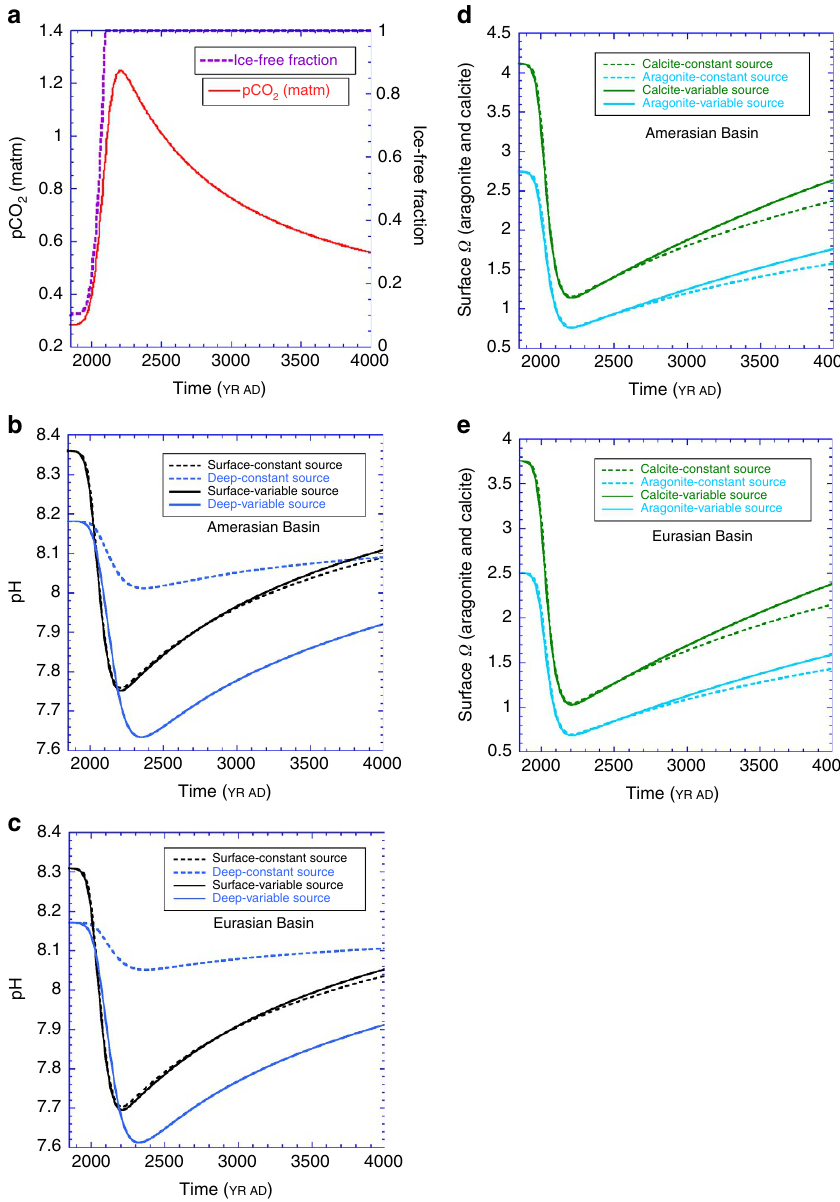
Figure 3 | Calculated pH and surface CaCO 3 saturation of the Arctic basins. ( a ) The pCO 2 created by the extended IS92a carbon emission scenario 24 and the ice-free fraction of the surface Arctic Ocean 3 as used in these calculated results. ( b , c ) pH in surface box and deep box (average) in Amerasian Basin and Eurasian Basin, respectively. ( d , e ) Carbonate saturation state for both aragonite and calcite in surface box in Amerasian Basin and Eurasian Basin,